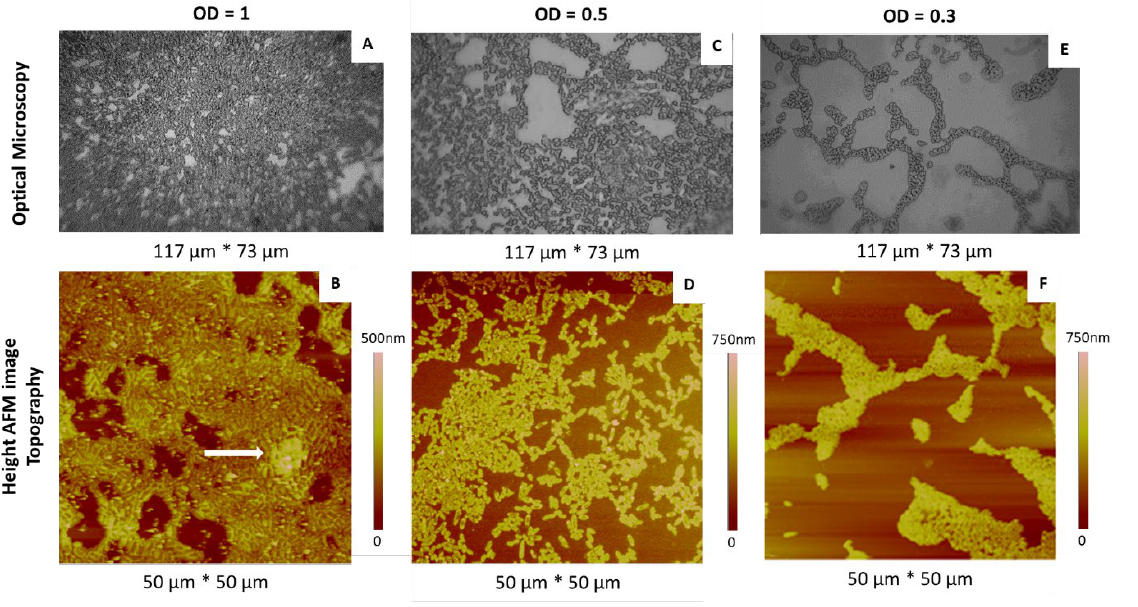
Figure 1. OM ( A , C , E ) and AFM height ( B , D , F ) images of P. fluorescens deposits made by simple deposition from suspensions at different O.D. values (O.D. = 1.0, images ( A , B ); O.D. = 0.5, images ( C , D ); O.D. = 0.3, images ( E , F )).